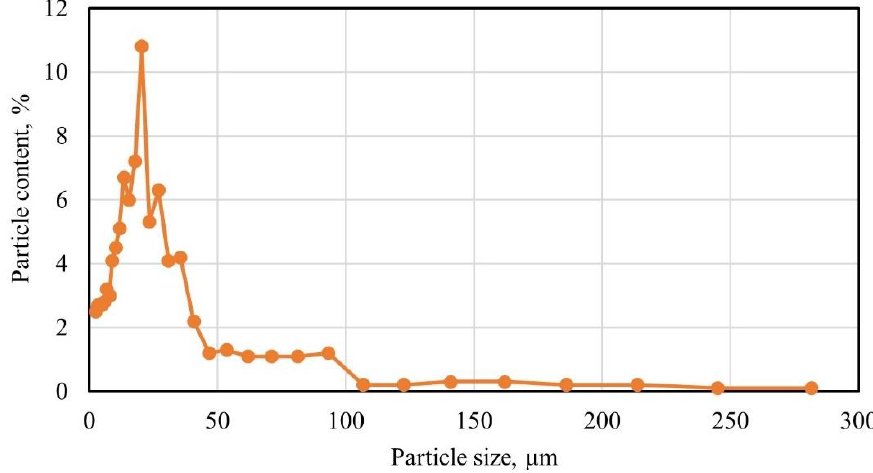
Figure 2. Granulometric composition of micro silica. The micro silica particle size distribution plot shows that most of the particles (more than 80%) have a size of 2 to 40 µm, with the main peak at 20 µm. X-ray phase analysis of micro silica particles is shown in Figure 3.